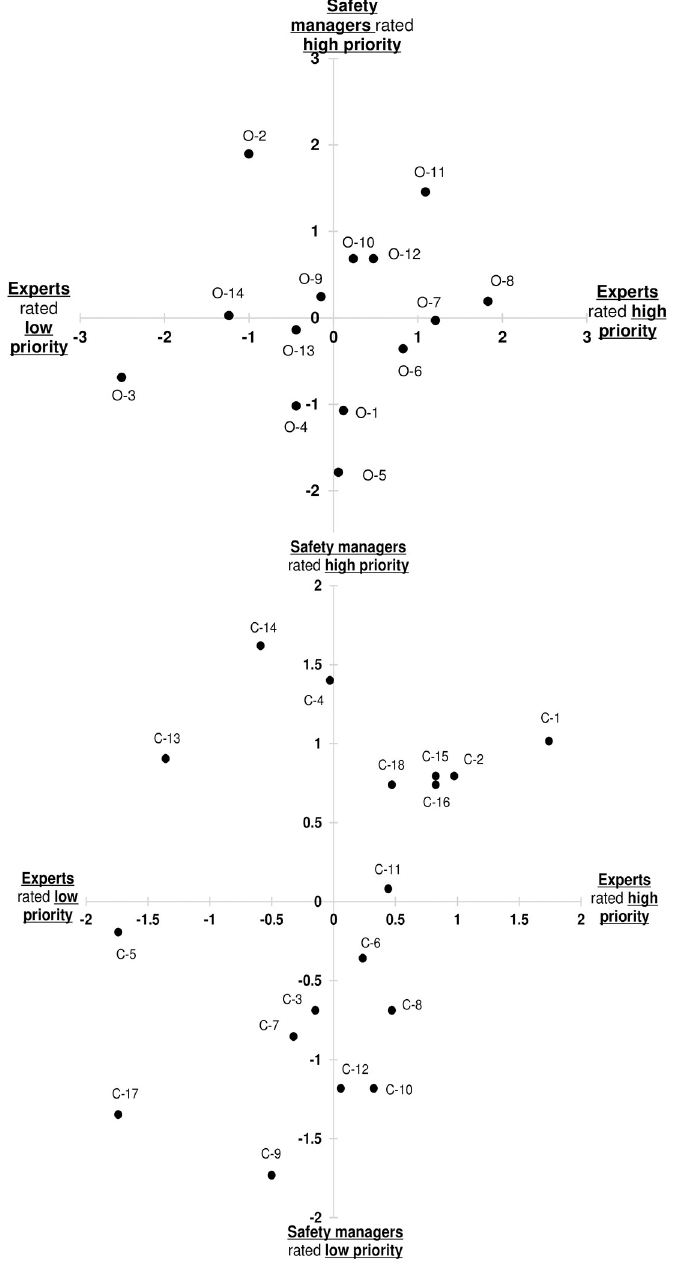
Fig 1. a. Priority of patient safety interventions (Organizational level). b. Priority of patient safety interventions (Clinical